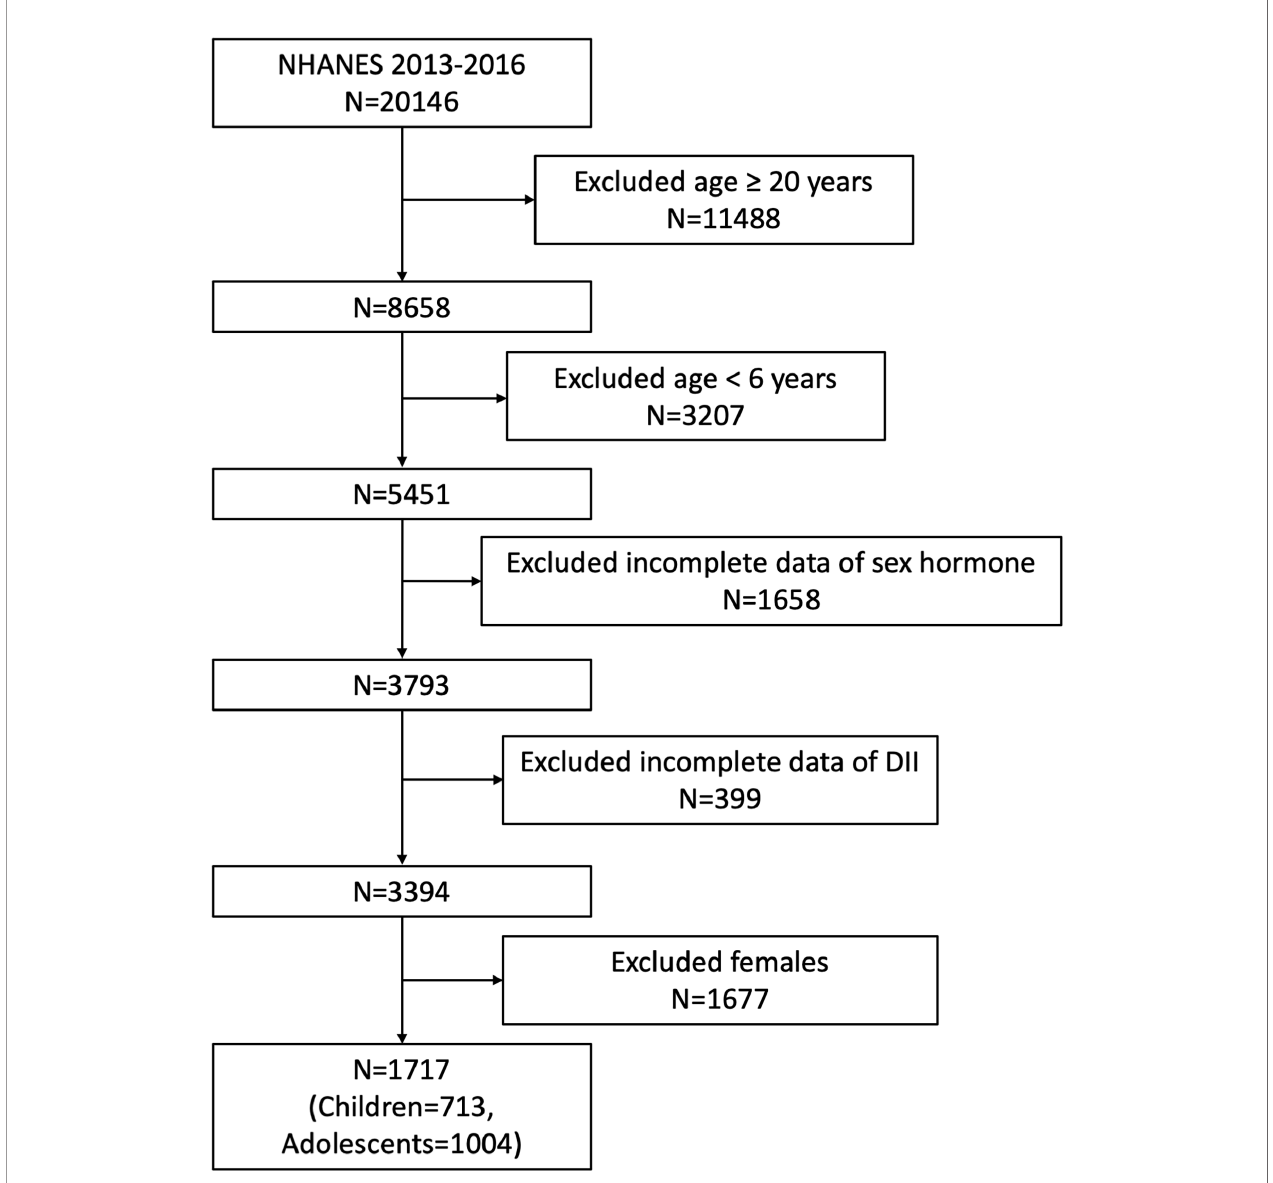
FIGURE 1 | Flowchart of the sample selection from NHANES